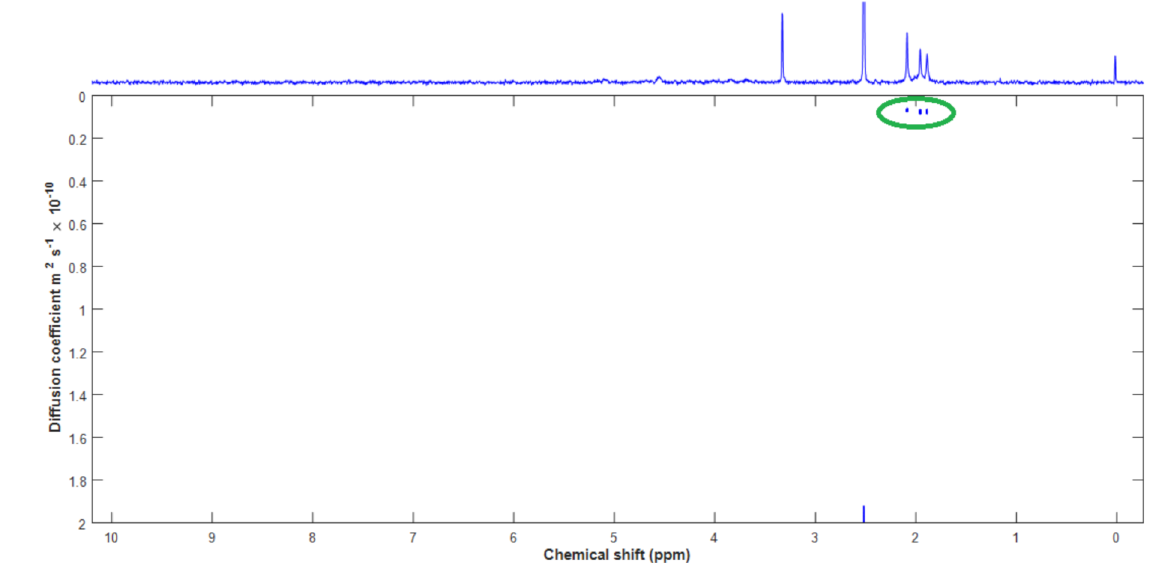
Figure 8. 1 H-detected DOSY of commercially available cellulose triacetate dissolved in DMSO -d 6 with a diffusion rate of about 0.8 · 10 − 11 m 2 · s − 1 (D value scale as before for comparison).